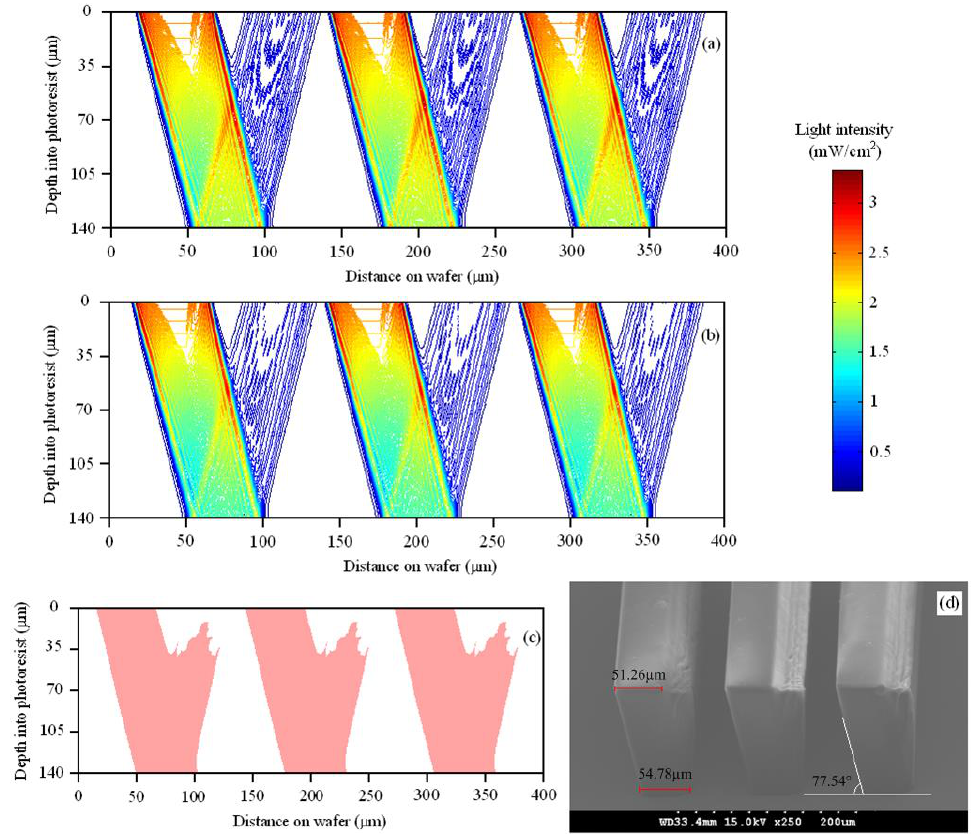
Figure 9. Simulation and experimental results of the inclined lithography of the SU-8 for 23.5° UV incident angle with reflected UV on bare silicon wafer: exposure time = 240 s, development time = 12 min, line/space = 50/75 μm. ( a ) Predicted light intensity distribution at the beginning of the exposure process; ( b ) predicted light intensity distribution at the end of the exposure process; ( c ) simulation result; and ( d ) experimental result. Reproduced with permission from [44].